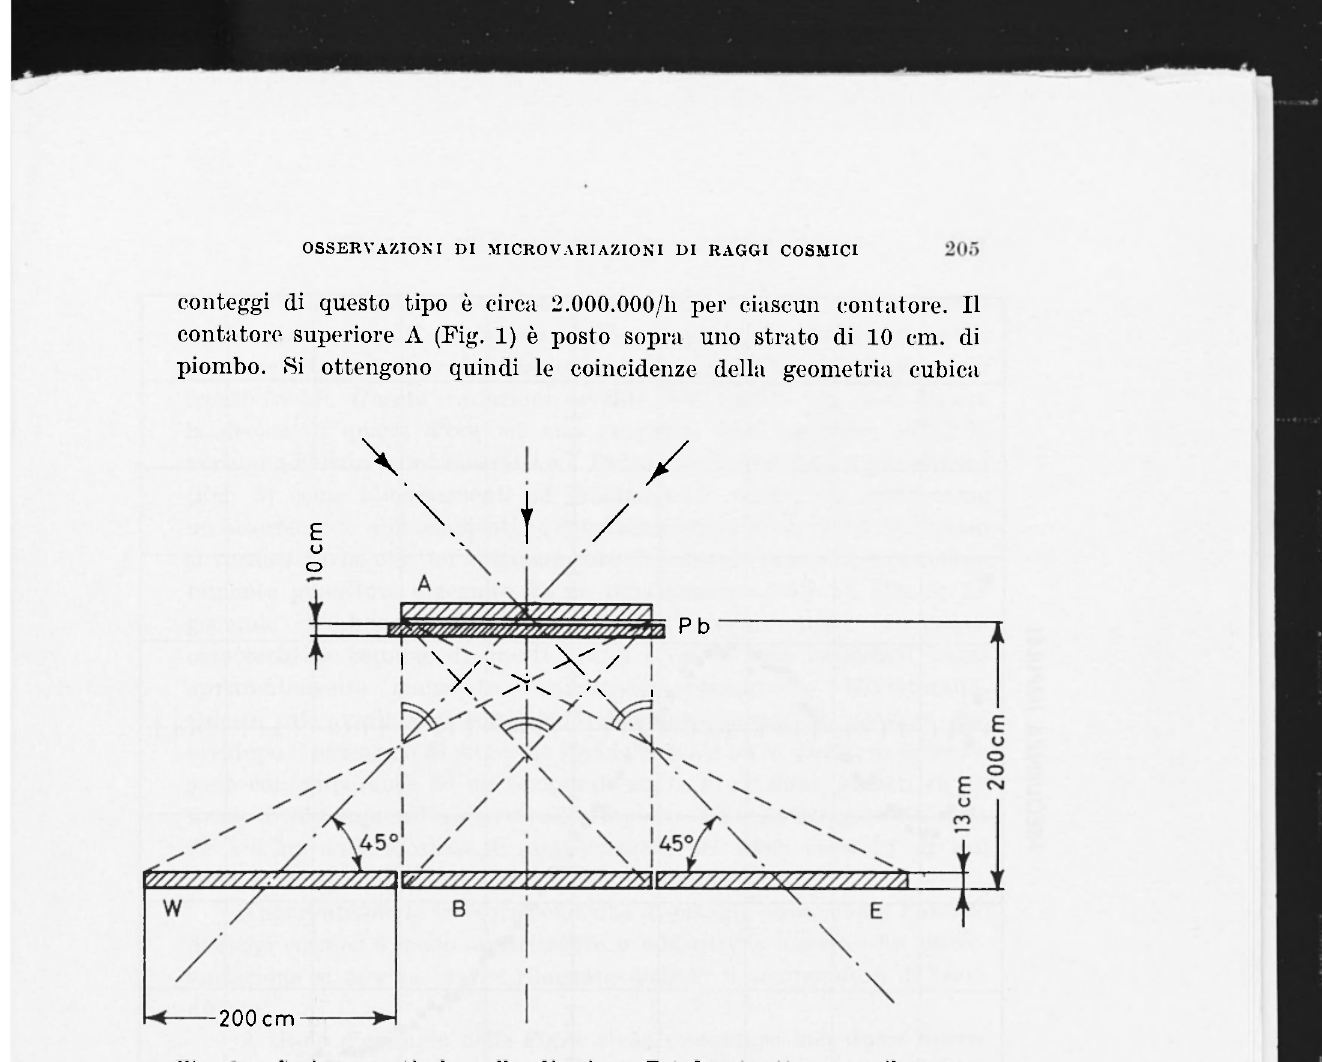
Fig. 1 - Sezione verticale nella direzione Est-Ovest attraverso il super- monitore di Bologna mostrante la posizione dei pannelli di